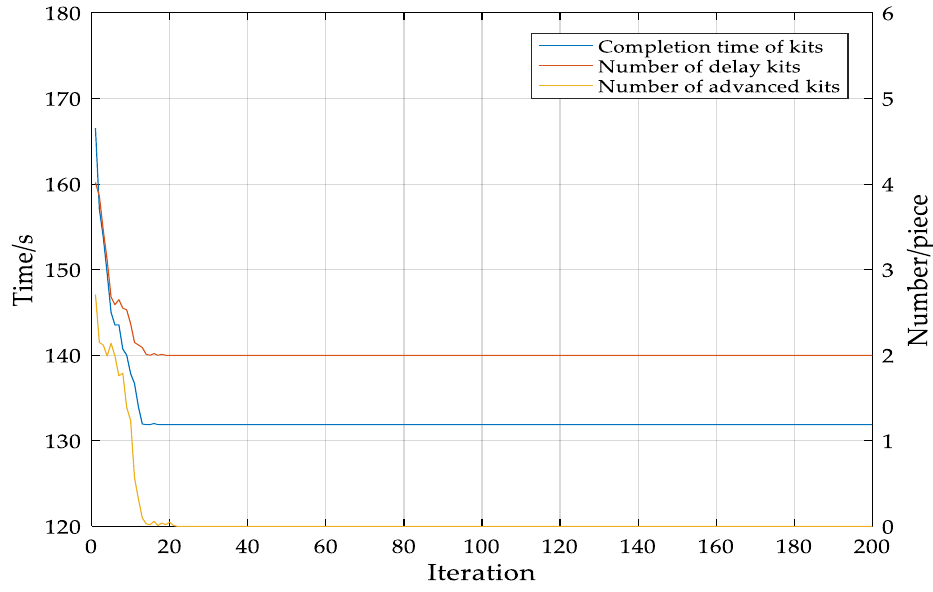
2 and f 3 . , f 2 and f 3 . 3 3 3 3 3